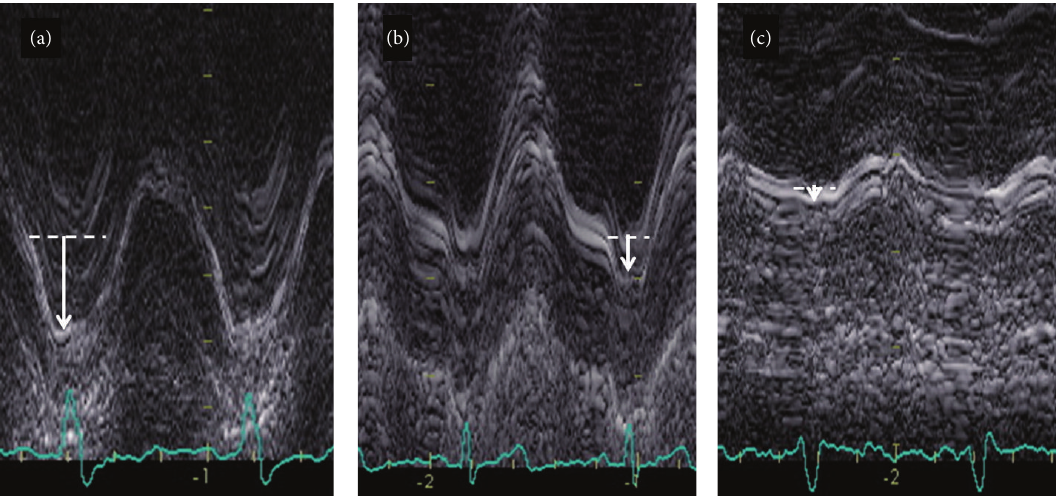
Figure 3: MAa M-mode images are shown to demonstrate the observed differences in MAa. (a) shows the M-mode tracing that is a representative MAa image of a patient with stage 1 LVDD. (b) demonstrates a representative MAa of a patient with stage 2 LVDD and (c) an MAa tracing of a patient with stage 3 LVDD. Solid lines represent site of measurement while the arrows represent actual MAa measure. Please note the relative magnitude of each MAa by the size of the